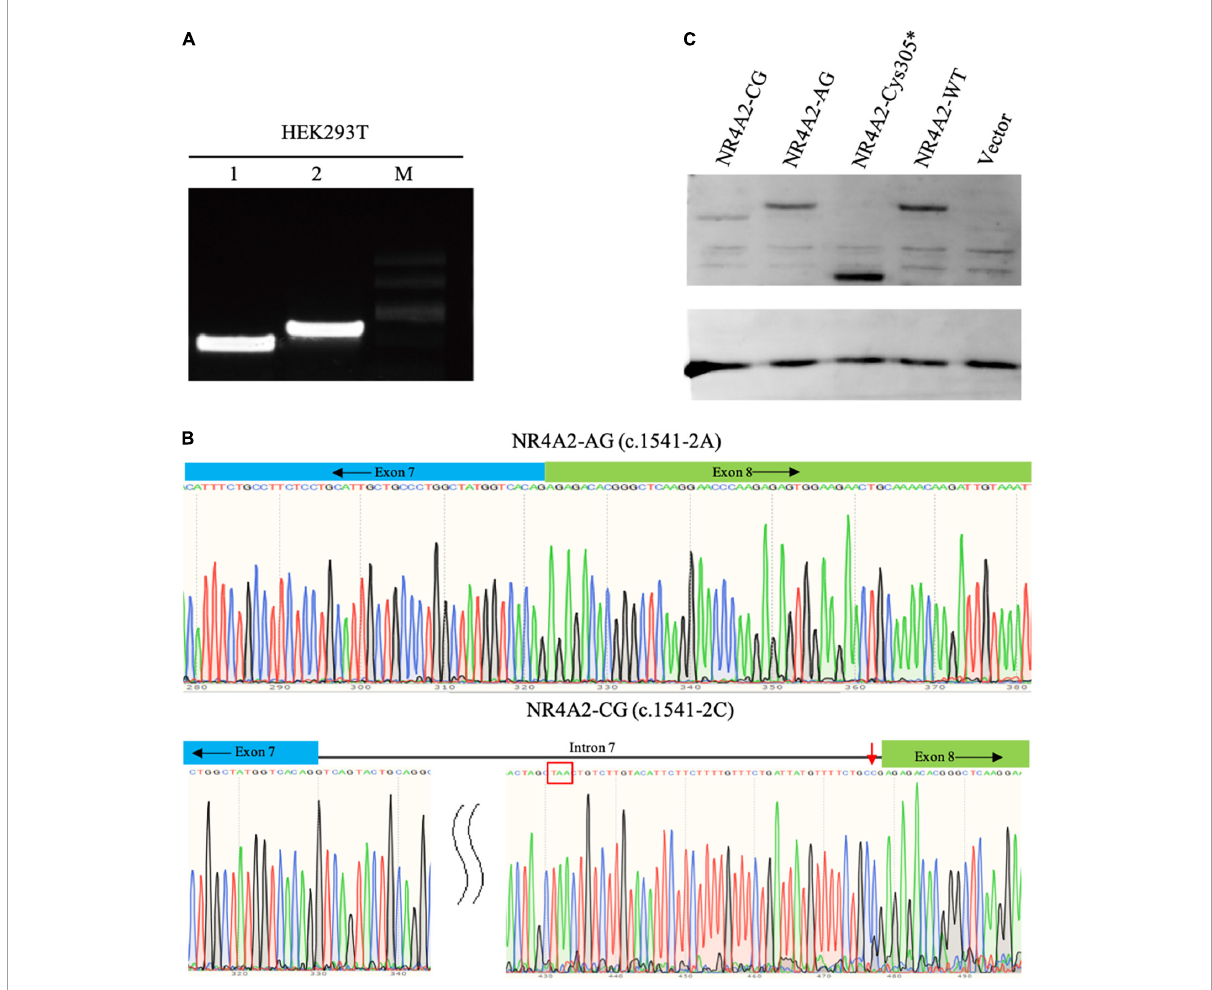
FIGURE2 Functional analyses of two NR4A2 variants: c.1541-2A > C and c.915C > A. (A) Agarose gel electrophoresis analysis of the RT-PCR amplification products: 1-NR4A2-AG construct; 2-NR4A2-CG construct; M-marker. (B) Sequence analyses of the PCR amplification products of the target fragment of NR4A2-AG and NR4A2-CG. NR4A2-CG resulted in the retention of intron 7 and an early termination codon TAA (red box). (C) Protein expression analyses of NR4A2 with c.915C > A or c.1541-2A > C variants. Both c.915C > A and c.1541-2A > C caused a truncated NR4A2